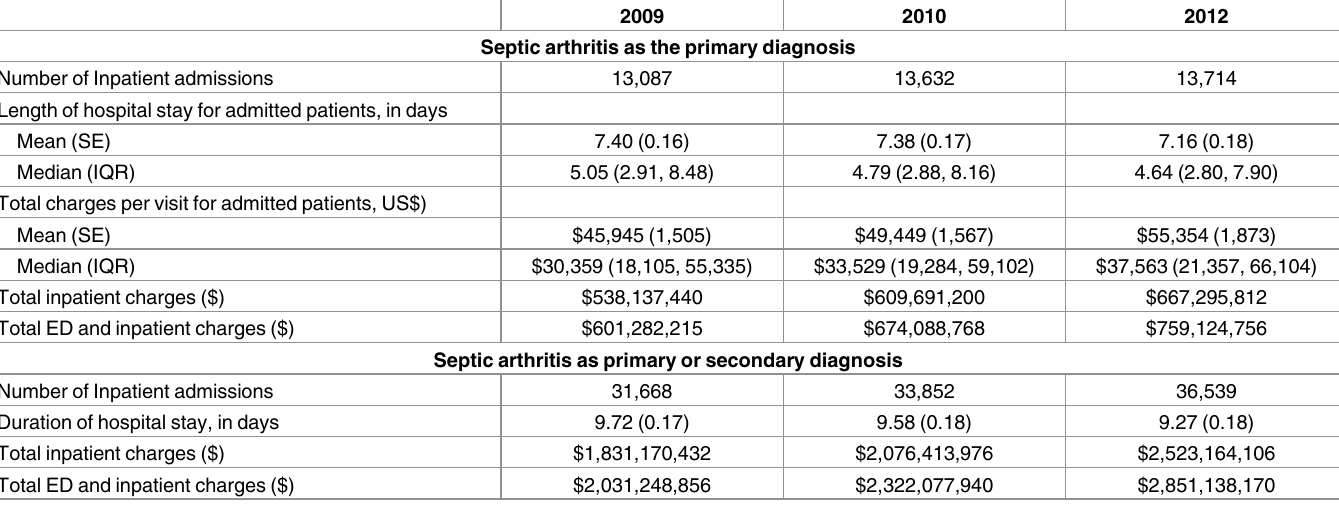
Table 1. Descriptivestatistics for utilization and charges for hospitalizations with septic